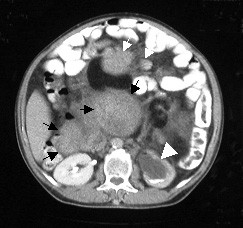
Abdominal CT image of slightly more distal of figure 2 shows multiple, mesenteric (white small arrows) and retroperitoneal (black arrows), well-defined, homogenous, solid masses. There is also grade 3 hydronephrosis in the left kidney (white arrowhead)